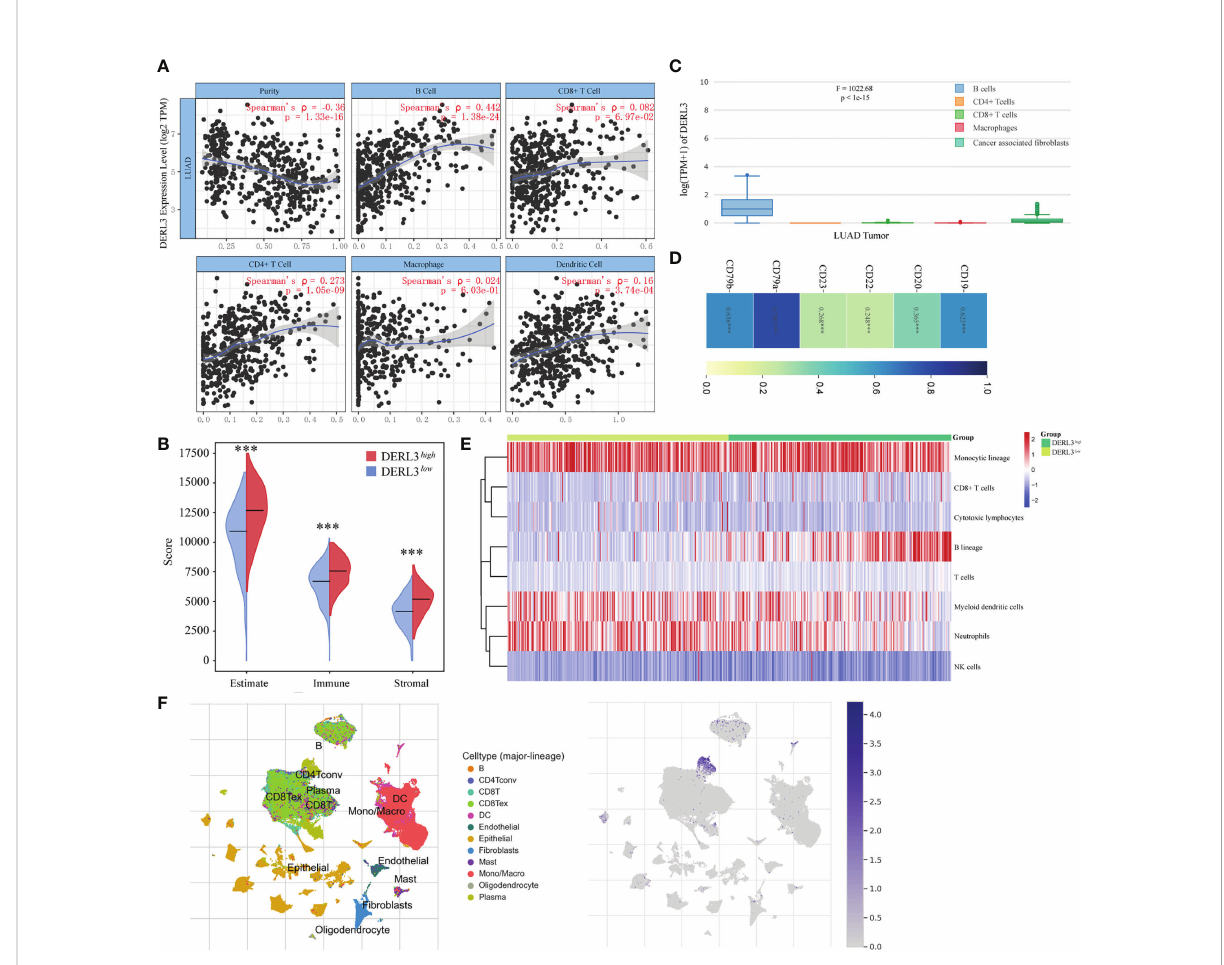
FIGURE 3 Characteristics of DERL3 in immune cells in fi ltration. (A) Relationship between DERL3 expression and immune in fi ltration level generated from TIMER. (B) Differential expression level of DERL3 with immune scores and stromal scores in LUAD. (C) DERL3 expression levels in different immune cells. (D) Correlations between cell surface biomarkers of B cells and DERL3 expression. (E) Clustering of MCP ‐ counter scores for the correlation of DERL3 with immune and non-immune stromal cell populations in LUAD according to TCGA databases. (F) Distribution of DERL3 gene signature expressed in immune cell clusters based on TISCH databases. (***p <